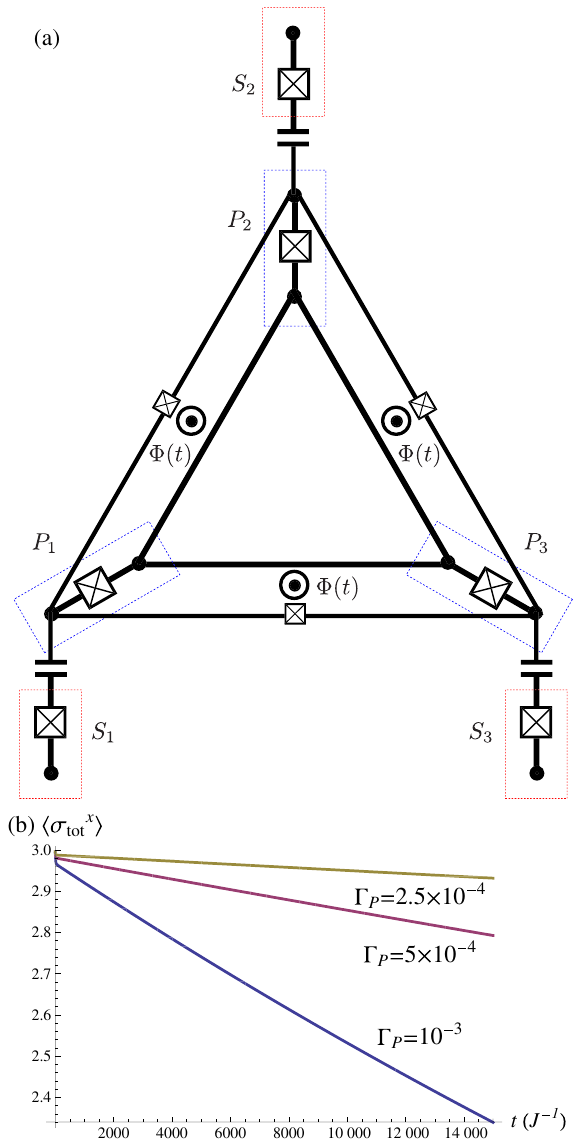
FIG. 6. A simple circuit to demonstrate passive error correction. (a) Ring of three primary superconducting transmon qubits ( P 1 ; P 2 ; P 3 , outlined in blue), coupled capacitively to three shadow qubits ( S 1 ; S 2 ; S 3 , outlined in red). The small Josephson couplings that link the primary qubits are biased by a time- dependent flux Φ ð t Þ , which implements the two-photon drive field. Combined with the internal capacitances of the junctions, σ x the resulting interaction is − J σ x in the rotating frame. As iP jP described in the text, the shadow lattice qubits rapidly correct single bit-flip errors, protecting both of the degenerate ground states of the primary lattice Hamiltonian. (b) Demonstration of 0 . 1 J state protection for this circuit, with g ¼ 0 . 05 J and Γ S ¼ 0 . 05 J ). We initialize the system in the ground state j 111 i ( Γ R ¼ and numerically integrate the Lindblad equations for the full 10 − 3 ; 5 × 10 − 4 ; 2 . 5 × 10 − 4 g J , the system ’ s evolution. For Γ P ¼ f observed decay rates for the ground states j 000 i and j 111 i are f 4 . 6 × 10 − 5 ; 1 . 3 × 10 − 5 ; 3 . 8 × 10 − 6 g , demonstrating the effec- tiveness of the error